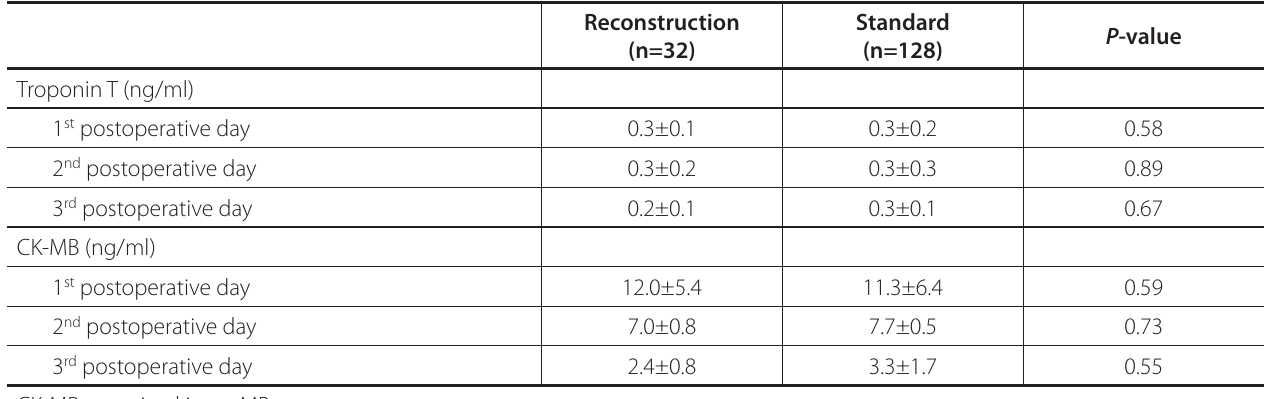
Table 3 . Postoperative levels of myocardial enzymes.